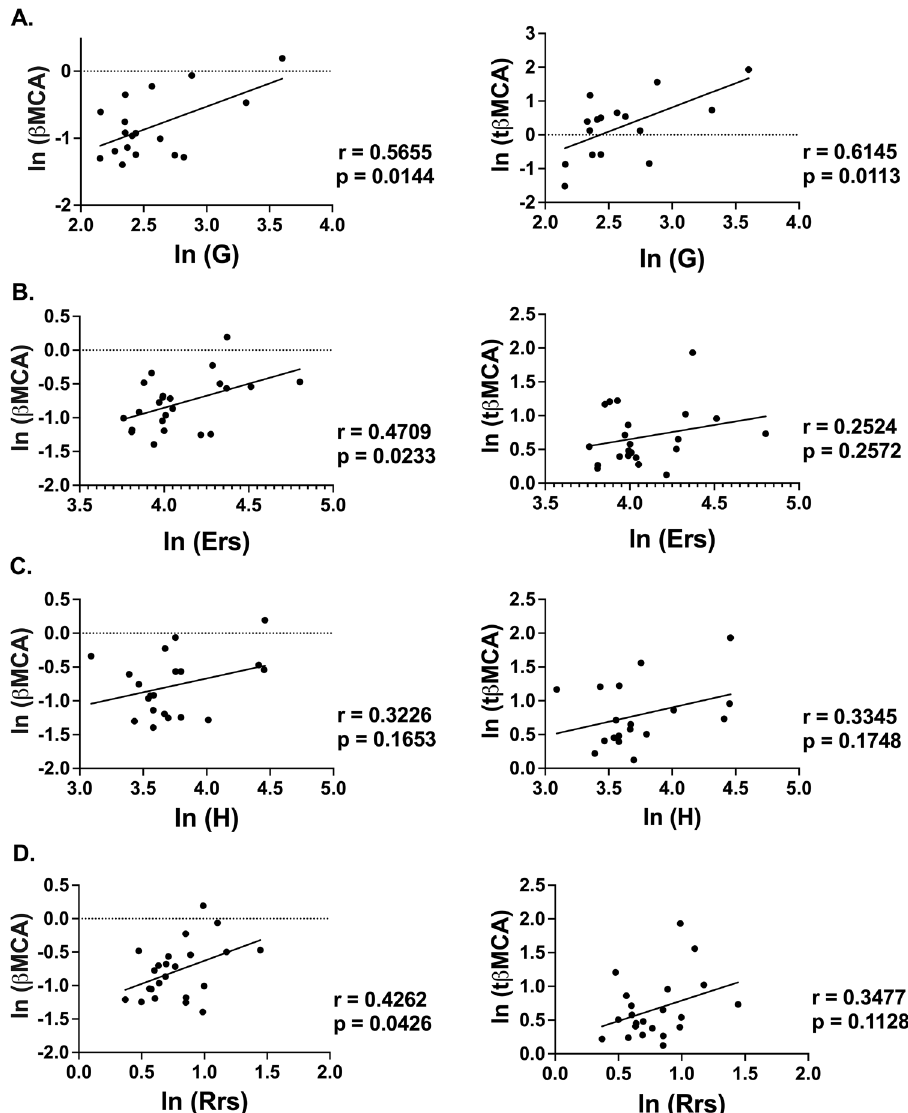
Figure 5. βMCA and tβ-MCA correlate with a decline of lung function in obese mice. Pearson correlations of serum βMCA and tβMCA levels with tissue damping, G (A) , pulmonary elastance, Ers (B), tissue elastance, H (C) , and pulmonary resistance, Rrs (D) measured by flexiVent following 50 mg/mL methacholine challenge in obese mice. n = 16–23 pairs. Graphs show natural log transformed data combined from four independent